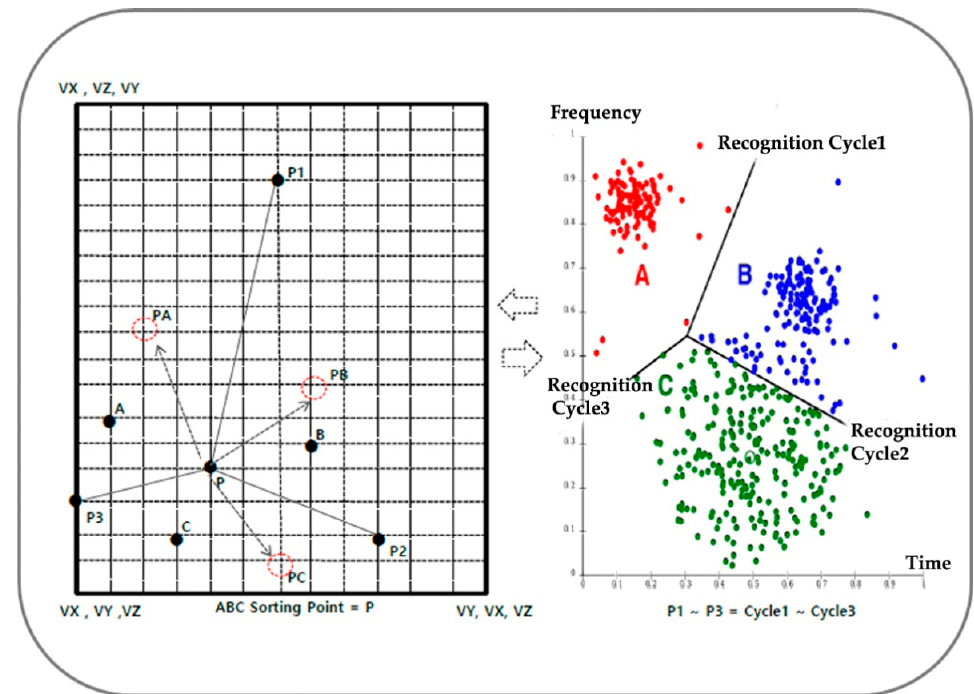
Figure 4. Two-dimensional location classification.